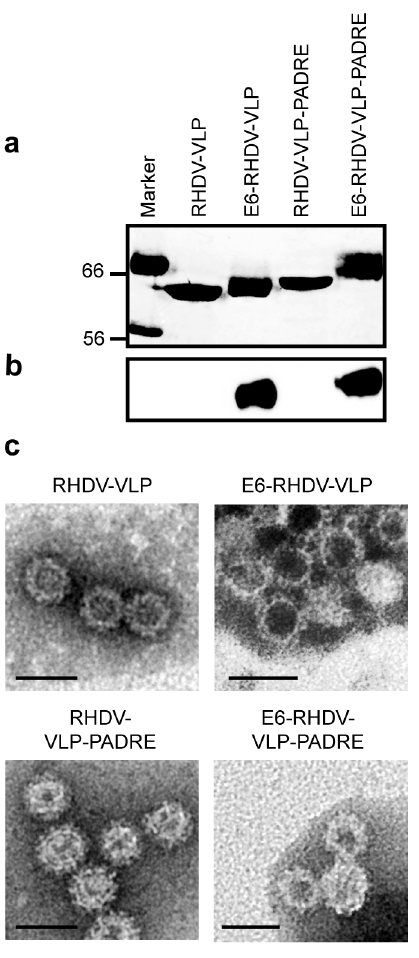
Figure 2. VLP purification and coupling of the E6 peptide. (a) 8% SDS-PAGE and corresponding western blot (b), probed with streptavidin-HRP, of purified RHDV-VLP and RHDV-VLP-PADRE uncou- pled or coupled with the biotinylated E6 peptide. Lane 1, Marker (kDa); 2, RHDV-VLP (2 m g); 3, E6-RHDV-VLP (4 m g); 4, RHDV-VLP-PADRE (2 m g); 5, E6-RHDV-VLP-PADRE (4 m g). Electron microscope analysis of purified RHDV-VLP, E6-RHDV-VLP, E6-RHDV-VLP-PADRE and RHDV-VLP-PADRE, confirming assembly (c), clockwise from top left, Bar =50